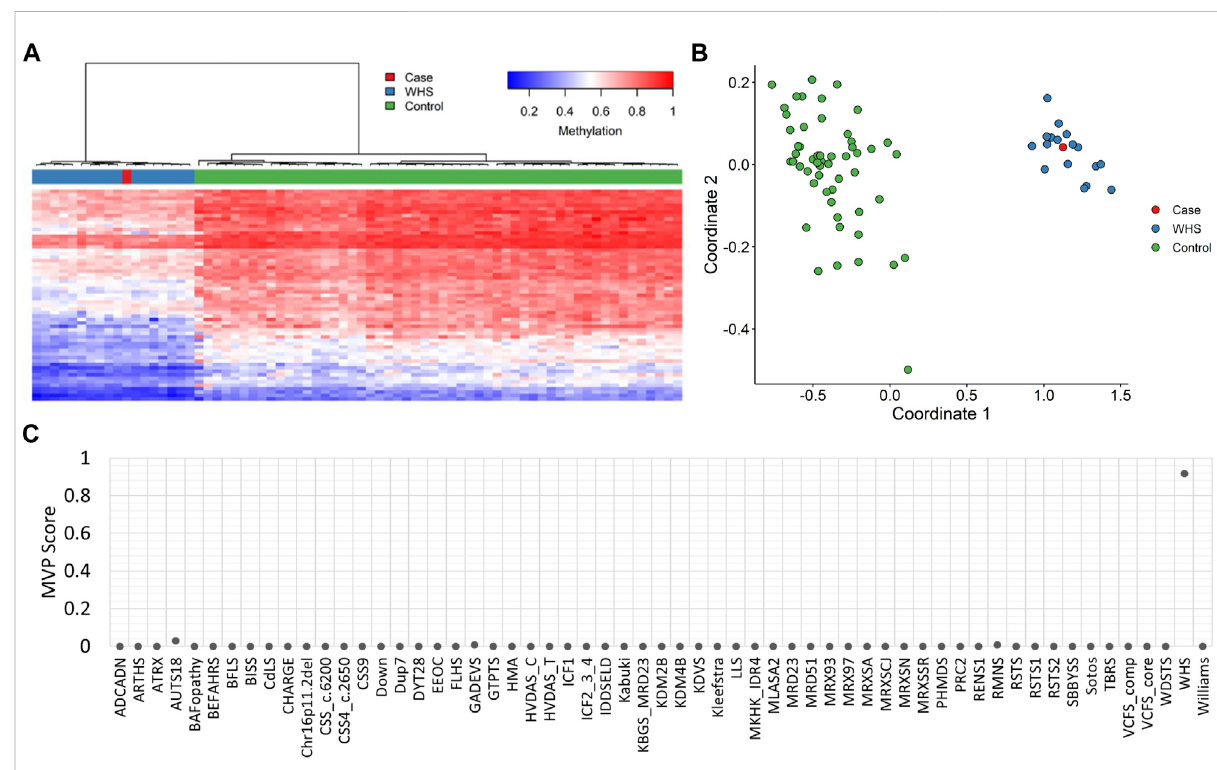
FIGURE 2 EpiSignTM DNA methylation analysis of peripheral blood from a patient with a negative microarray (A) Hierarchical clustering and (B) multidimensional scaling plots indicate that the patient (purple) has a DNA methylation signature similar to subjects with a con fi rmed WHS episignature (red) and distinct from controls (green). Each row of the heatmap represents one CpG probe on the DNA methylation array, and each column represents one individual ’ s sample. The heatmap color scale from blue to red represents the DNA methylation level (beta value) from 0 (no methylation) to 1 (fully methylated). (C) MVP score, a multiclass supervised classi fi cation system capable of discerning between multiple episignaturesbygeneratingaprobabilityscoreforeachepisignature.TheelevatedpatientscoreforWHScomparedtoothersyndromessuggestsan episignature similar to the WHS reference